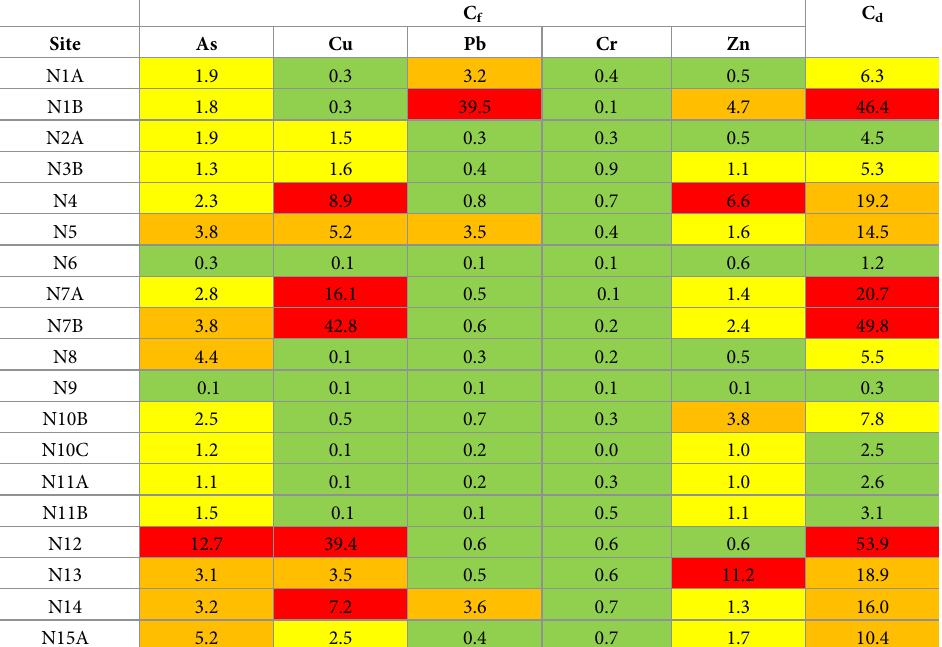
Table 1. Contamination factors (C f ) and degree of contamination (C d ) in sediments from 19 lakes assessed through a modified version of the model developed by H å kanson [22]. Cells with values for C f < 1 and C d < 5 are colored green, yellow for 1 < Cf < 3 and 5 < Cd < 10, orange for 3 < Cf < 6 and 10 < Cd < 20, and red for 6 < Cf and 20 < Cd. C f C